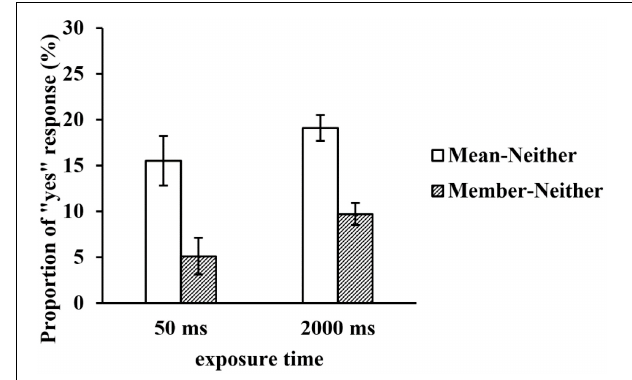
FIGURE 4 | The proportion of “yes” responses to the test faces in a large set at two exposure times. * p < 0.05, ** p < 0.01, *** p < 0.001. SEMs are shown.